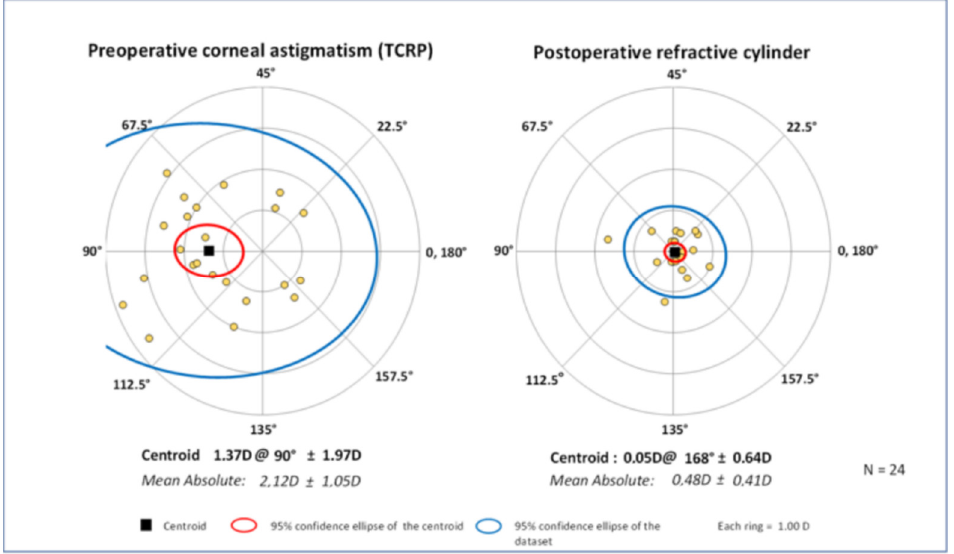
Figure 2. Double-angle plots of preoperative corneal astigmatism (TCRP) and postoperative refractive cylinder in the digital group ( n = 24).